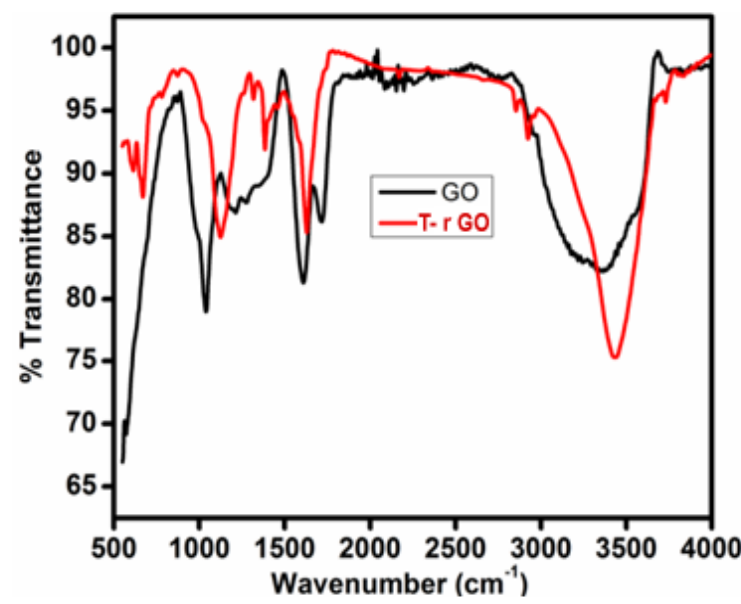
Figure 3. FTIR spectral analysis of (black line) GO and (red line) T-rGO.